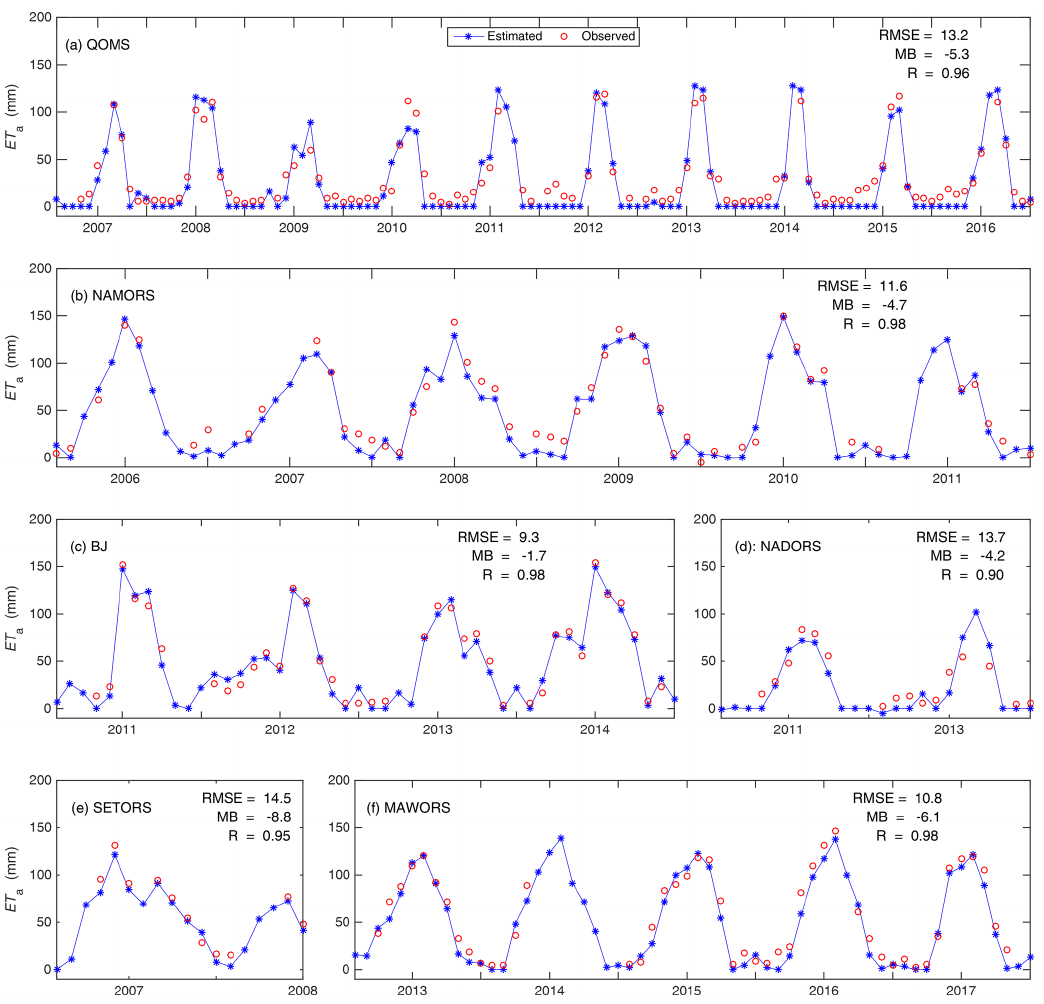
Figure 2. SEBS-estimated and EC-observed monthly ET a at the six stations (a–f) on the TP in years when the latter observations were available. RMSE is the root-mean-square error, MB is the mean bias, and R is the correlation coefficient.